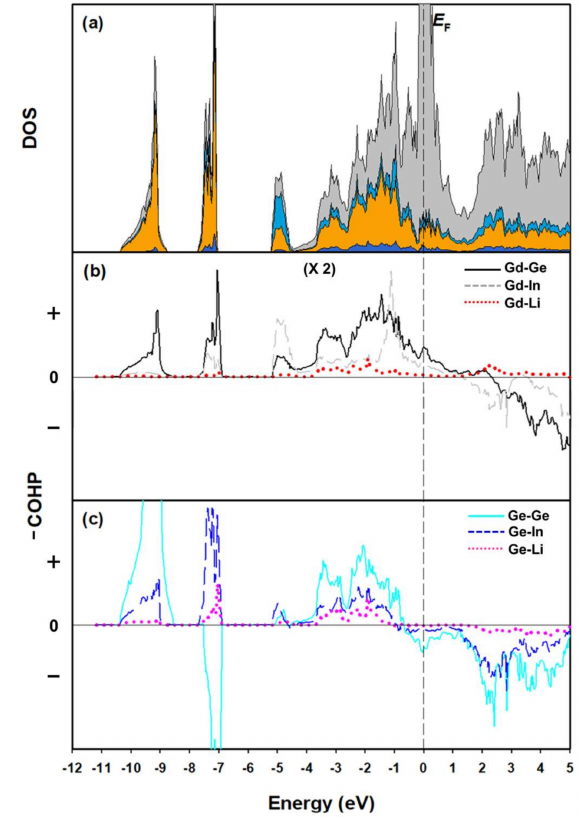
Figure 5. DOS and COHP curves of Gd 2 In 0.5 Li 0.5 Ge 2 . ( a ) TDOS (solid-black line), Gd PDOS (gray region), In PDOS (light-blue region), Ge PDOS (orange region), and Li PDOS (blue region). Six COHP curves represent interatomic interactions ( b ) for the distorted-pentagonal prismatic coordinate environment surrounding the central Gd, and ( c ) among three anionic elements. E F (dashed vertical line) is the energy reference (0